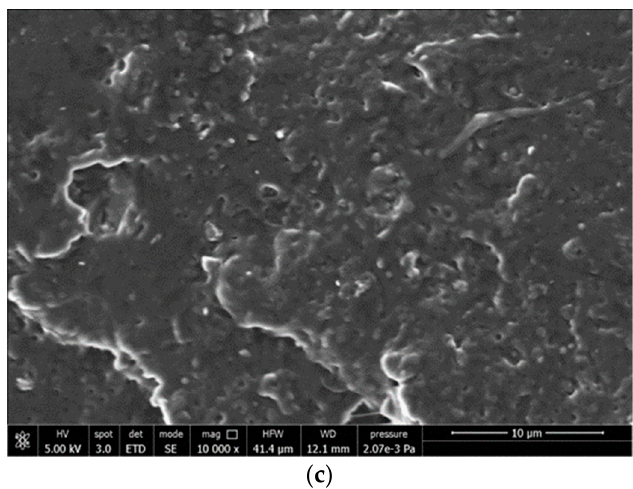
Figure 7. SEM micrographs recorded on cryo-fractured surfaces of ( a ) F1; ( b ) F2; ( c ) F3.